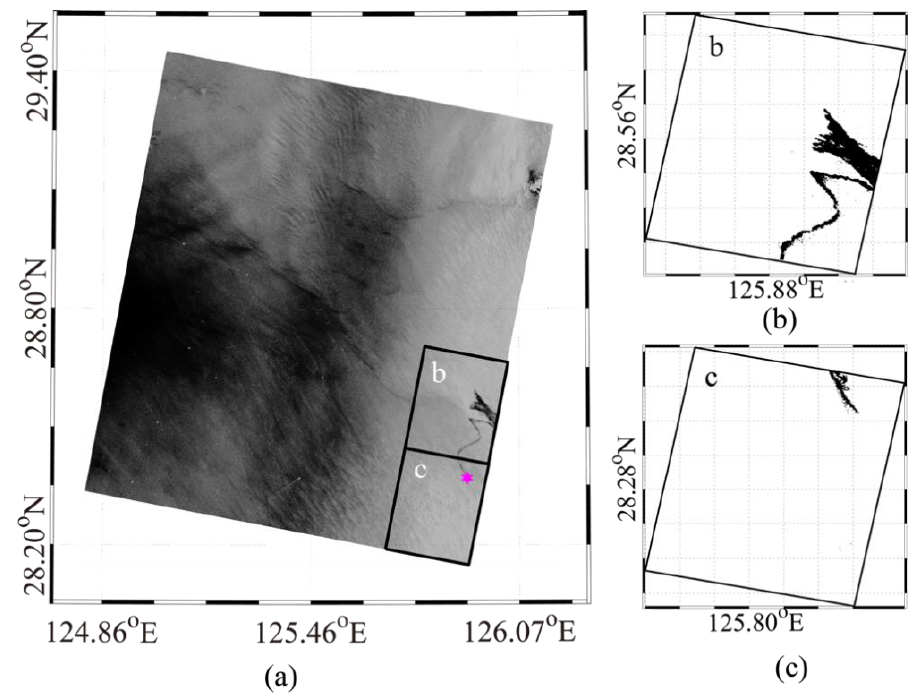
Figure 8. ( a ) The GF-3 SAR image on 15 January 2018 at 21:39, in which the pinkish marks represent the shipwreck position, and the sub-scenes b and c are used to extract spilled oil slicks; ( b ) The results of extracted oil slicks from sub-scene b, which are marked by black spots; and ( c ) The results of extracted oil-slicks from sub-scene c.